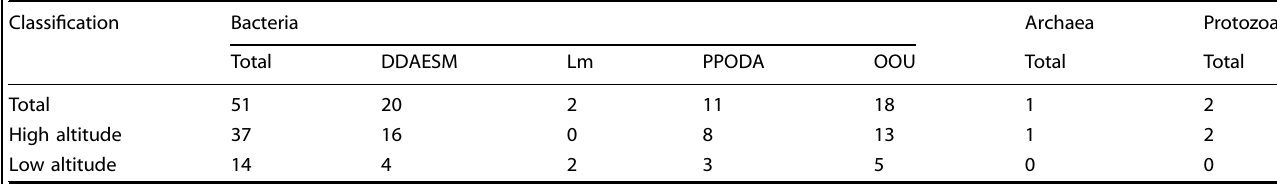
Table 1. Classi fi cation of gut microbiota with signi fi cant differences (LefSe test) in abundance between high-altitude and low-altitude populations of rhesus macaques.